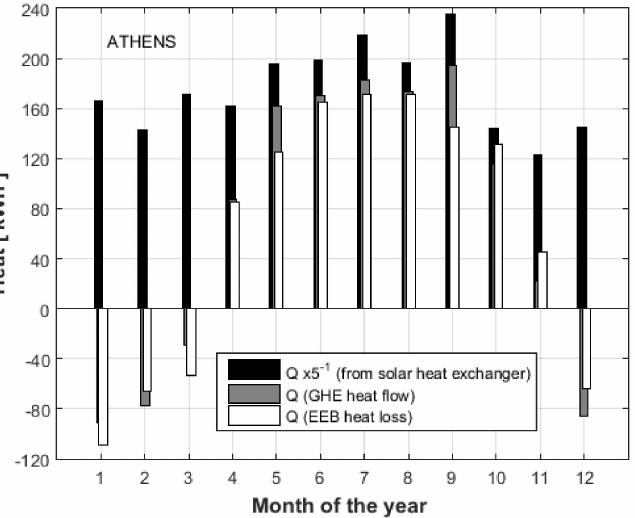
Figure 10. Monthly heat flow across the EEB for Athens, for the scenario of 12 PVTs paired with 12 BHEs and for the 6th year of simulation.